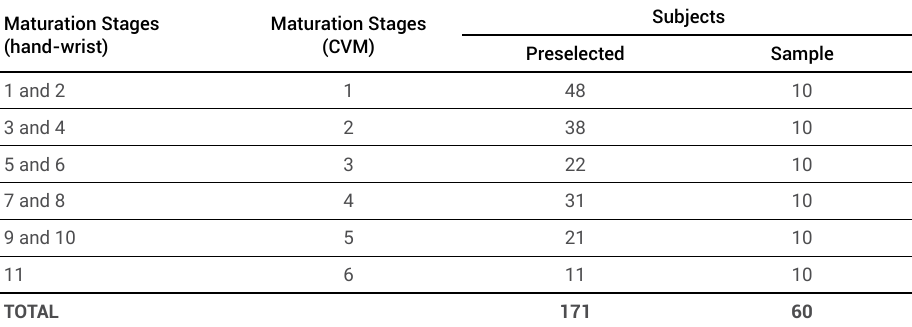
Table 1. Distribution of the 171 subjects preselected accordingly to skeletal maturation stages through Fishman 19 and Hassel and Farman’s 14 methods. Maturation Stages